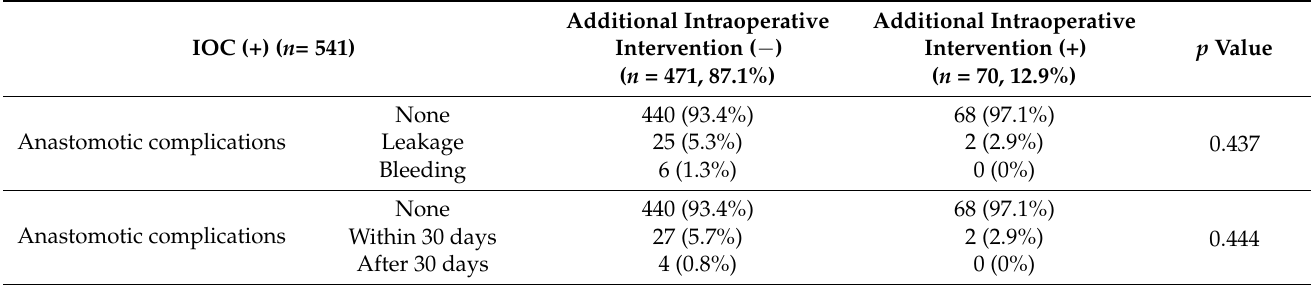
Table 4. Comparison of anastomotic complication rates based on the additional intraoperative intervention.